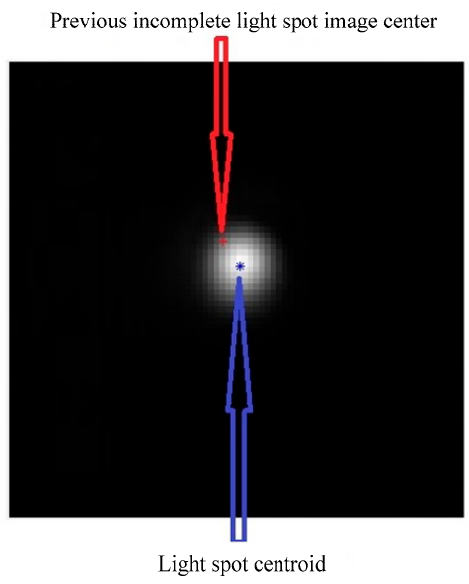
Figure 12. Relative positions of incomplete light spot image center and light spot centroid.